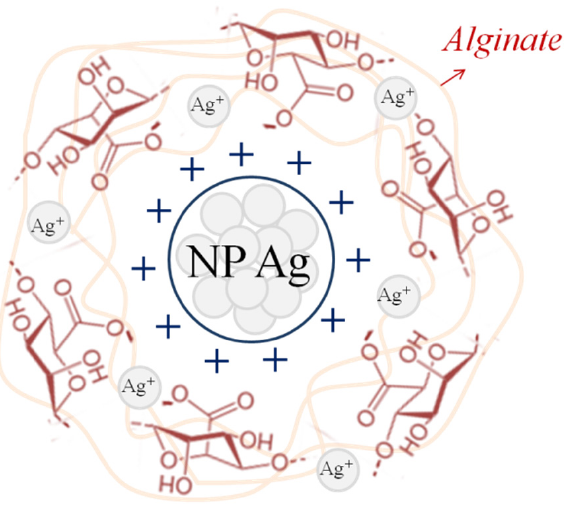
Figure 5. Schematic representation of the crosslinked polymer by nanoparticles (NP) Ag. At the same time, the reduction of silver cations does not occur completely, as washed and dried films show qualitative reactions to silver cations, causing the appearance of white and dark plaque on the surface when they are immersed in sodium chloride and sodium hydroxide, respectively. Thus, it can be argued that sodium alginate turns out